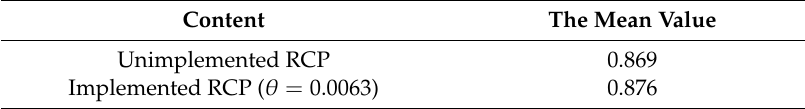
Table 5. The average value of water pollution control e ff ect in two situations.